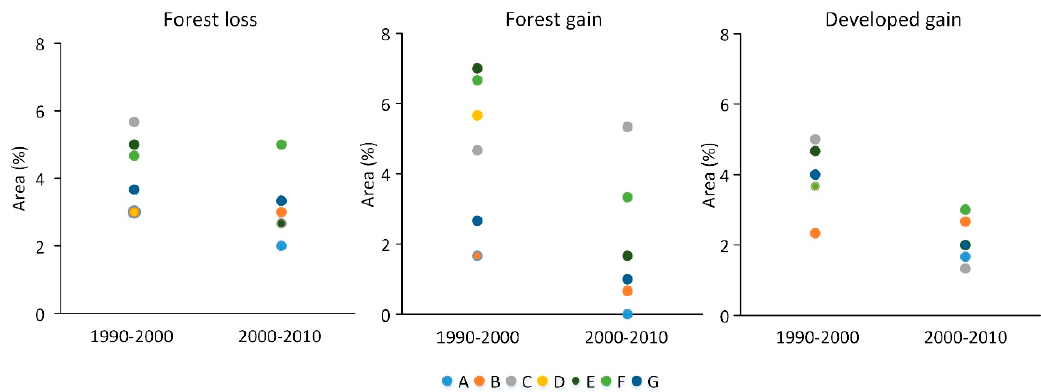
Figure 3. Estimated percent area of land cover change classes for each interpreter (A to G).